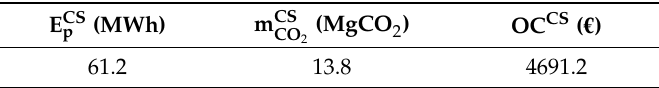
Table 6. Annual performances of the reference